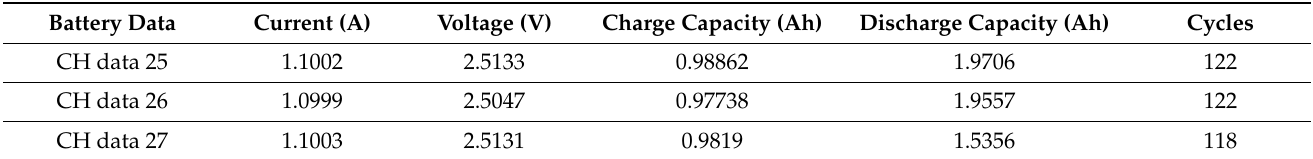
Table 2. Driving cycle